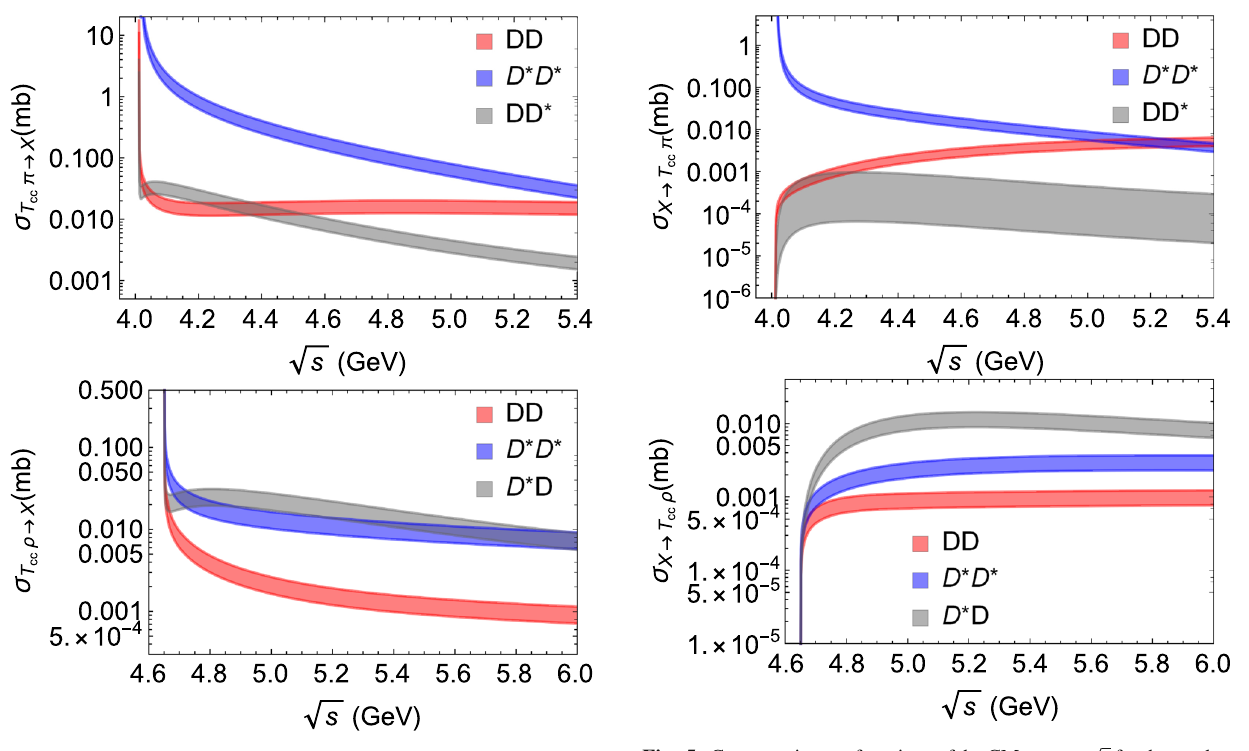
Fig. 4 Cross sections for the absorption processes T + cc π → D ( ∗ ) D ( ∗ ) (top panel) and T + cc ρ → D ( ∗ ) D ( ∗ ) (bottom panel), as functions of the √ s , taking the form factors obtained within the QCDSR CM energy approach